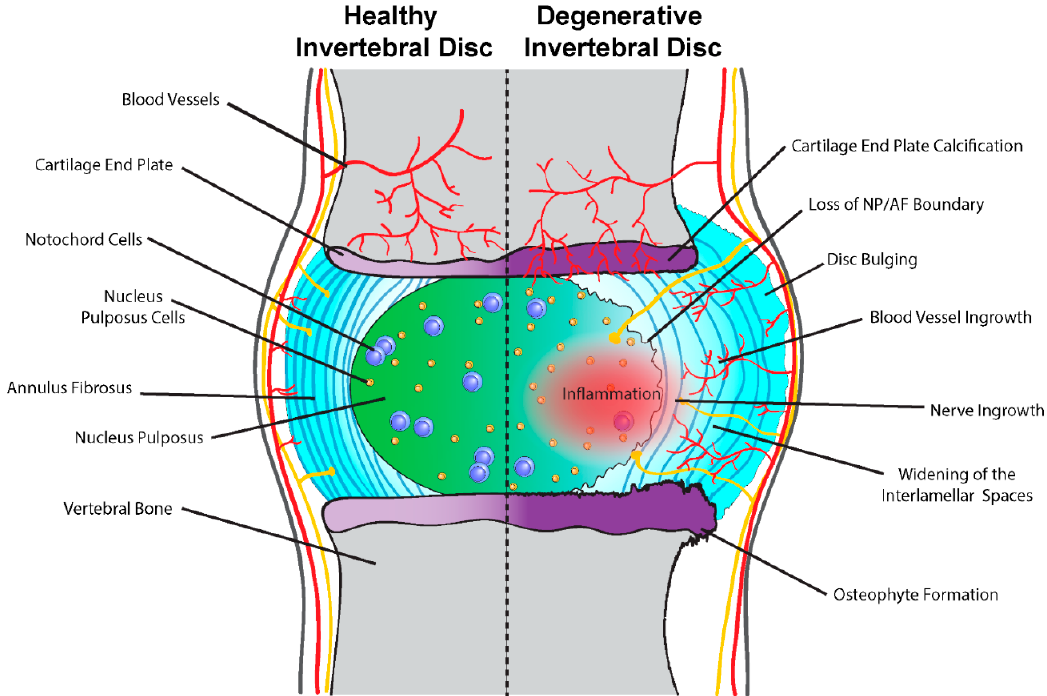
Figure 2. Schematic representation highlighting the hallmarks of human disc degeneration. Compared to healthy intervertebral disc, the degenerative disc has increased inflammation, blood vessel and neuronal ingrowth, loss of the boundary between the NP and annulus fibrosus (AF), and widening of the interlamellar space between collagen bundles in the AF that often results in disc bulging. In advanced degeneration the cartilage endplate calcifies and osteophytes form on the adjacent vertebral bones.